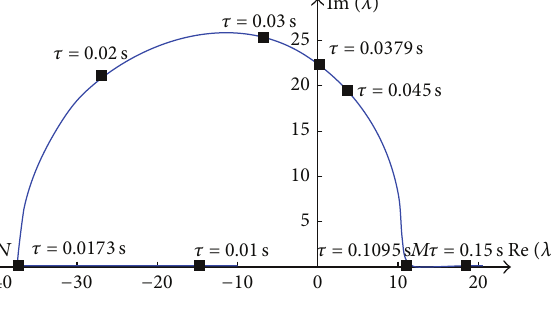
Figure 6: Curve of 𝜏 - 𝑧 . Figure 7: Curve of an